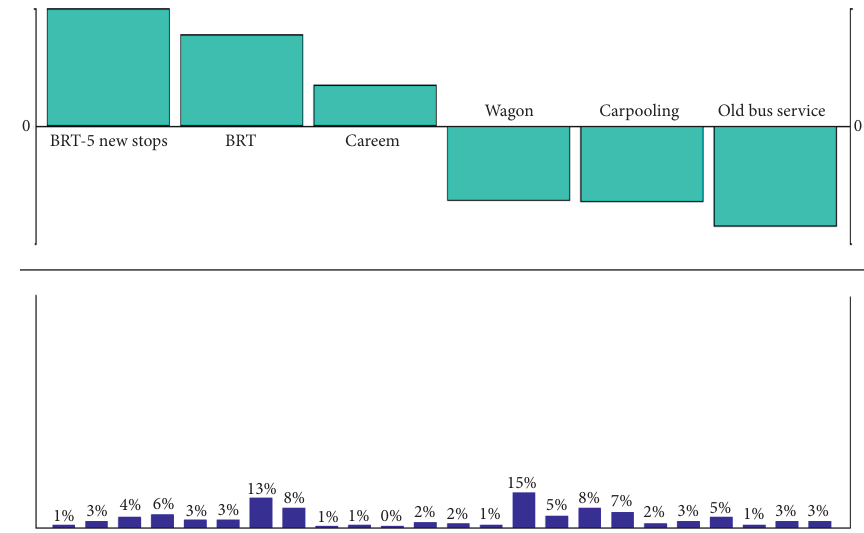
Figure 10: Range of alternative transport modes and weightings of criteria in the visual PROMETHEE